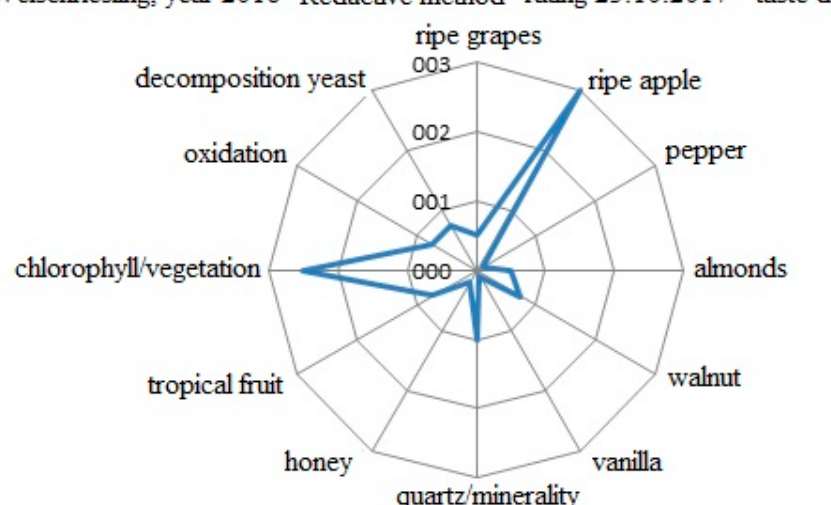
Figure 6. Evaluation of the specific taste descriptors for the W 2016 variant processed by the reductive method.